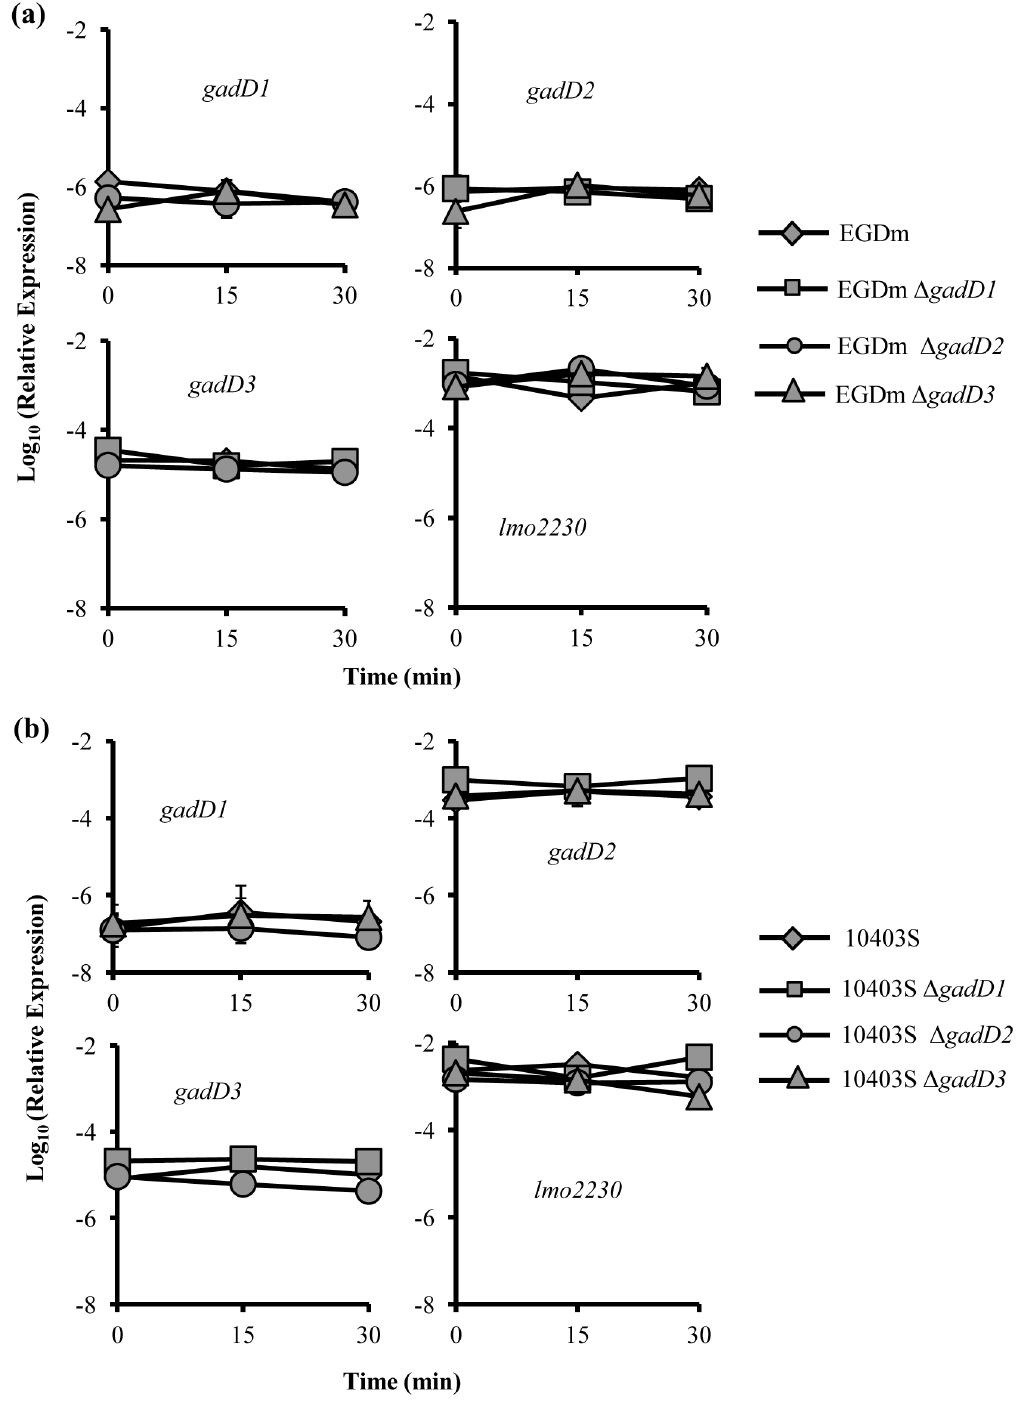
Figure 4. Relative expression of gad genes in response to acid treatment. Expression of gadD1 , gadD2 , gadD3 and lmo2230 relative to expression of the 16S rRNA gene prior to, 15 min and 30 min after exposure in BHI broth to pH 4.0 (EGDm (a) ) or pH 3.5 (10403S (b) ). Error bars represent the standard error in the mean of 3 independent biological repeats. Differences found to be significant between the genes at any time- point for each strain are shown with * Significance was determined where p , 0.05 as determined by a Student’s t -test. acid tolerance was compared between two commonly used 10403S to utilise both GAD i and GAD e in response to low pH. reference strains EGDm (murinised EGD-e) and 10403S. The Despite possessing the genes for a putative glutamate/GABA survival of 10403S during exposure to low pH is significantly antiporter, EGDm does not export GABA. This may be due to the greater than EGDm (Fig. 2) and this correlates with an ability of fact that the amino acid sequences of GadT2 are different at four